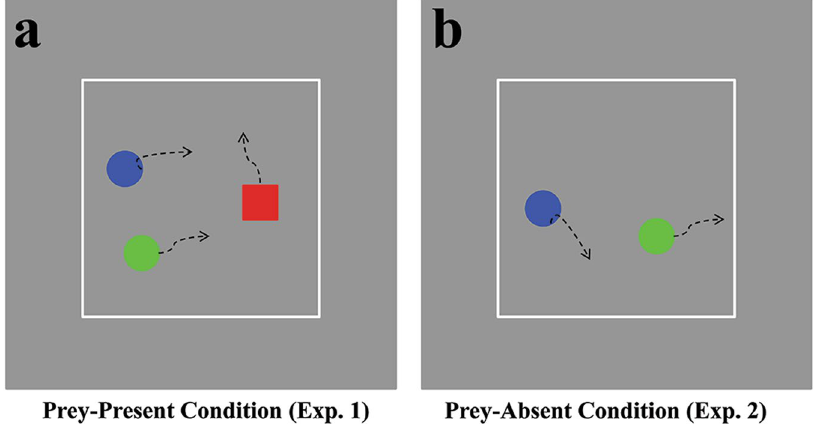
Figure 1. An illustration of chasing motion in two experiments. ( a ) and ( b ) Depict a sampled image from the dynamic display lasting 3 s in Experiment 1 and Experiment 2, respectively. The curved dashed arrows represent each agent’s motion; these were not present during